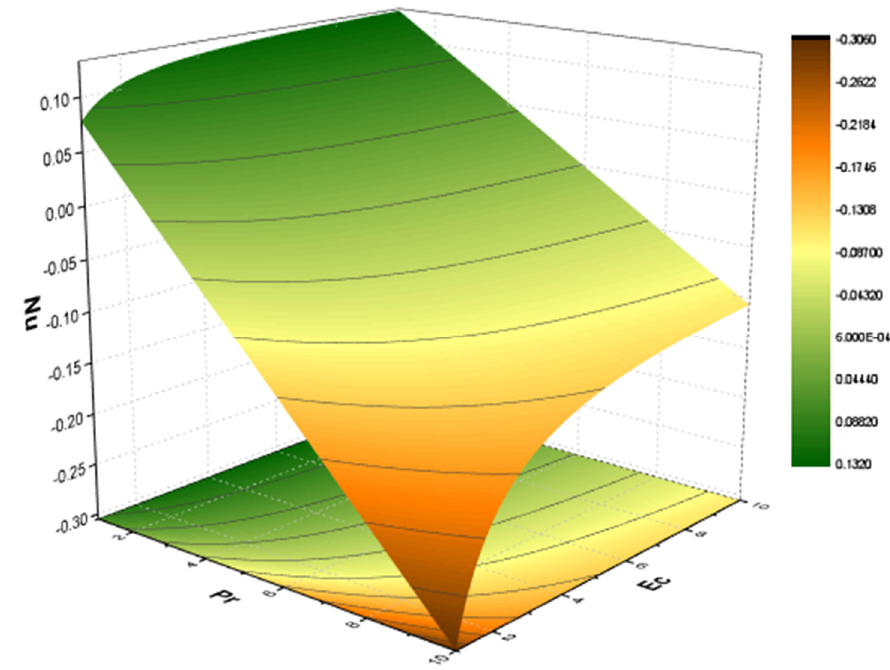
Figure 20. Impact of Ec on NN.